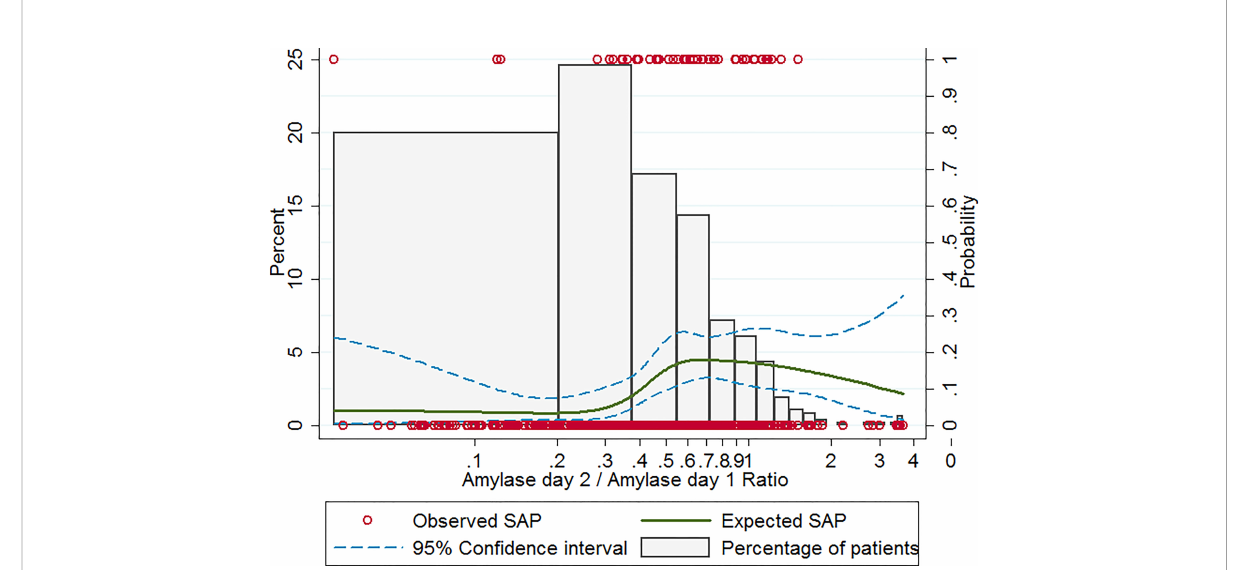
FIGURE 1 Observed and expected incidence of SAP in patients with different amylase ratio levels. Histograms show the percent distribution of study patients at different amylase ratio levels (the left-hand y-axis). The red circles give the observed incidence of SAP for each patient (the right- hand y-axis). The solid curve gives the expected incidence of SAP based on restricted cubic spline analysis (the right-hand y-axis). The dashed curves represent the 95% con fi dence intervals for the expected incidence of SAP (the right-hand y-axis). SAP, severe acute